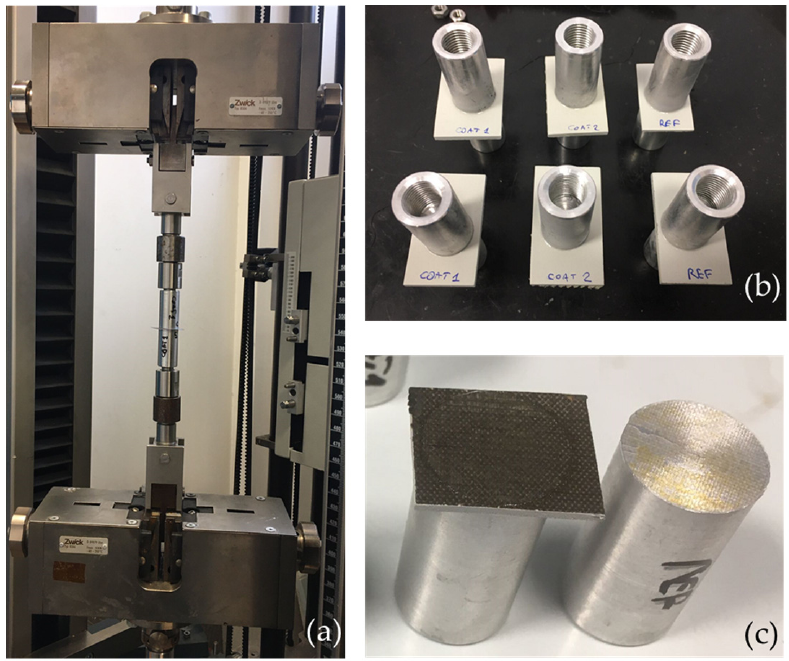
Figure 10. The Zwick Roll Z010 machine employed to perform the adhesion test ( a ), C samples before ( b ) and after the test ( c ).